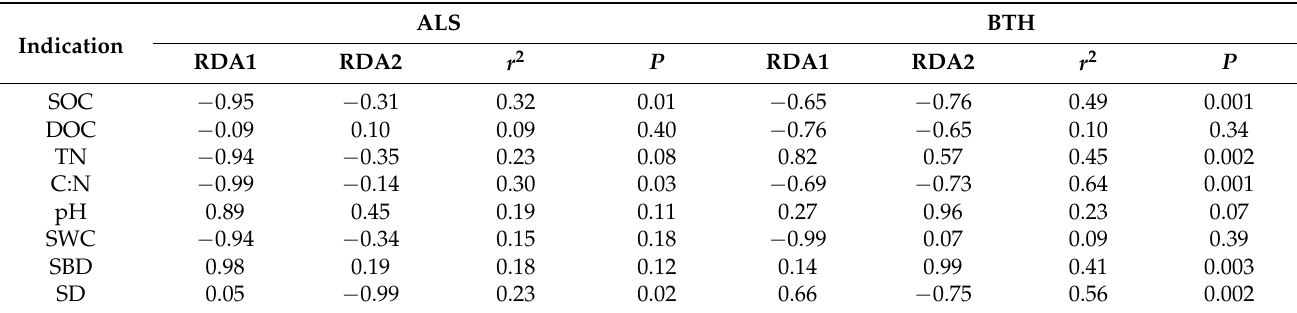
Table A2. Redundancy analysis statistics.